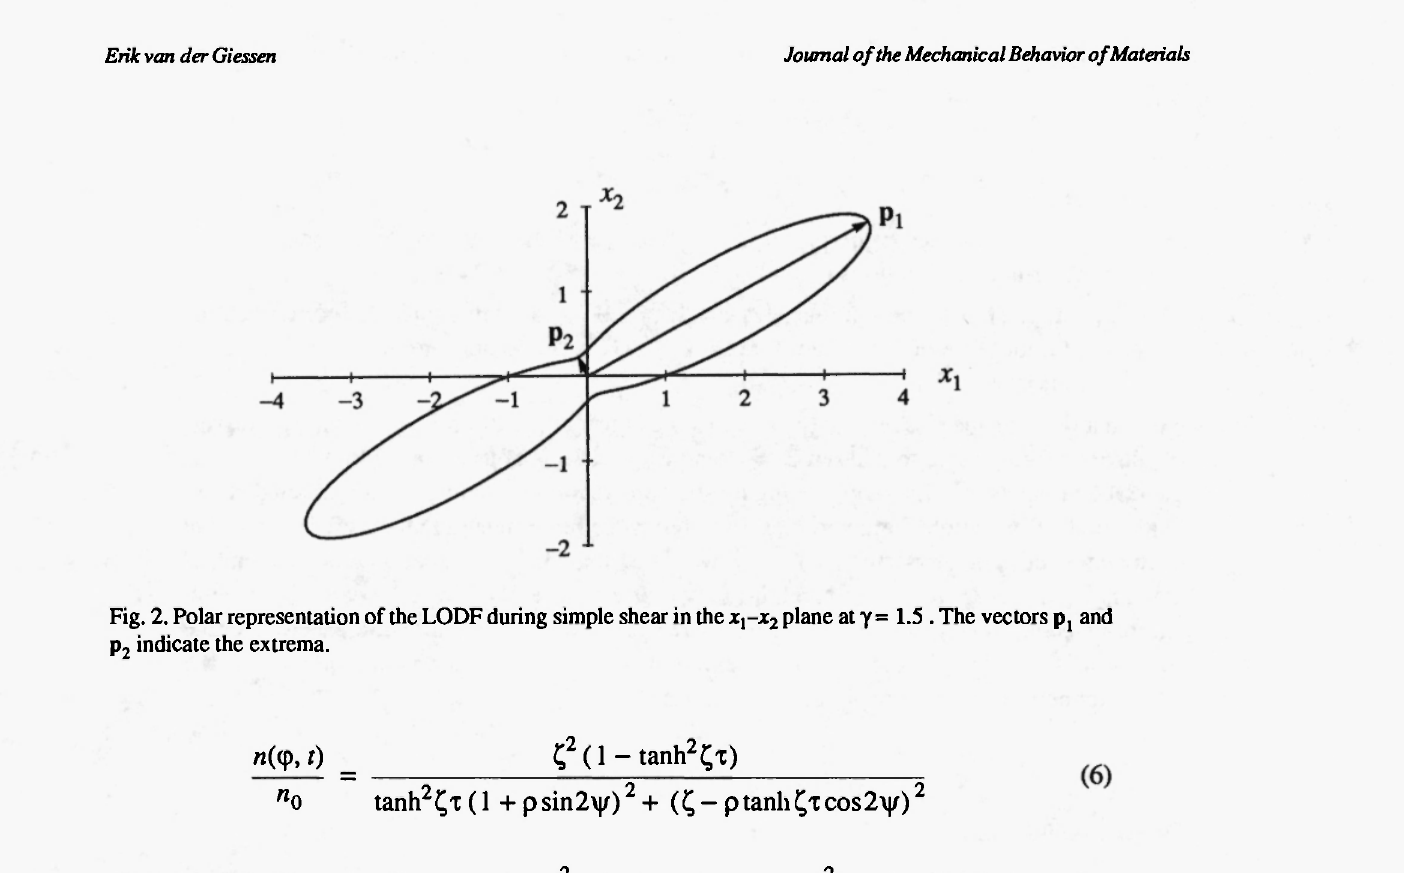
Fig. 2. Polar representation of the LODF during simple shear in the x\-x 2 plane at γ = 1.5 . The vectors Pj and p 2 indicate the